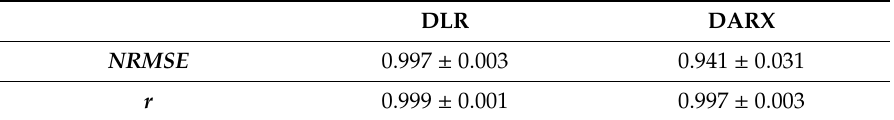
Table 3. Normalized root mean square error ( NRMSE ) and Pearson correlation coe ffi cient ( r ) evaluating the fitting agreement between the experimental data and the model output of the dynamic linear regression (DLR) model and a first order dynamic auto-regression with exogenous variables (DARX). DLR DARX NRMSE 0.997 ± 0.003 0.941 ± 0.031 r 0.999 ± 0.001 0.997 ± 0.003